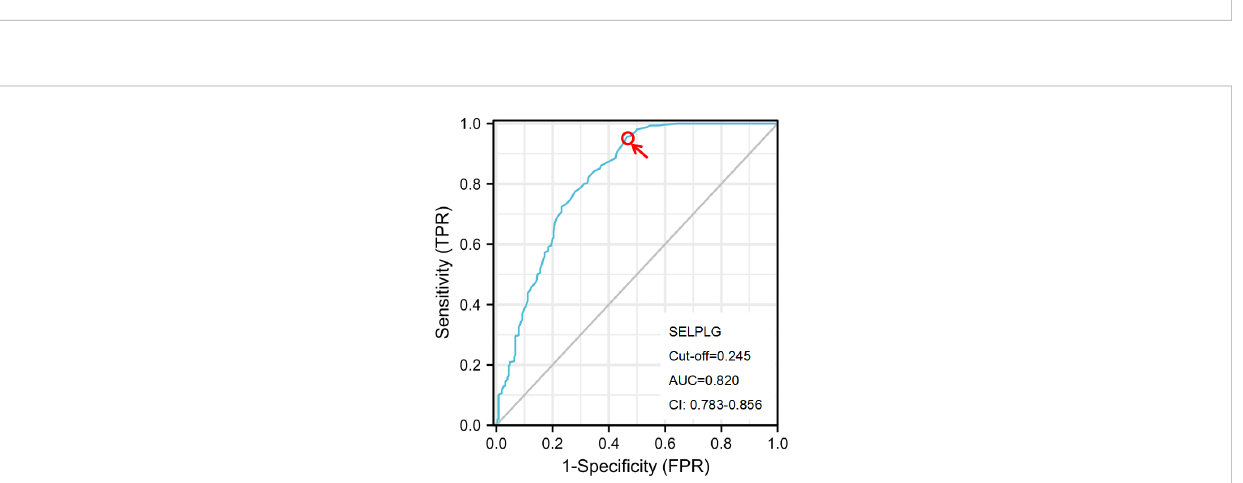
FIGURE 1 Expression patterns of PSGL-1 mRNA in cervical lesions. (A) The PSGL-1 expression increased with the development of cervical lesions. (B) PSGL-1 expression increased with the development of cervical cytology. (C – F) PSGL-1 expression in different HR-HPV genotyping. Analysis between two groups: Wilcoxon Rank sum test; NS: P= 0.05 or higher; *P < 0.05; ***P < 0.001.